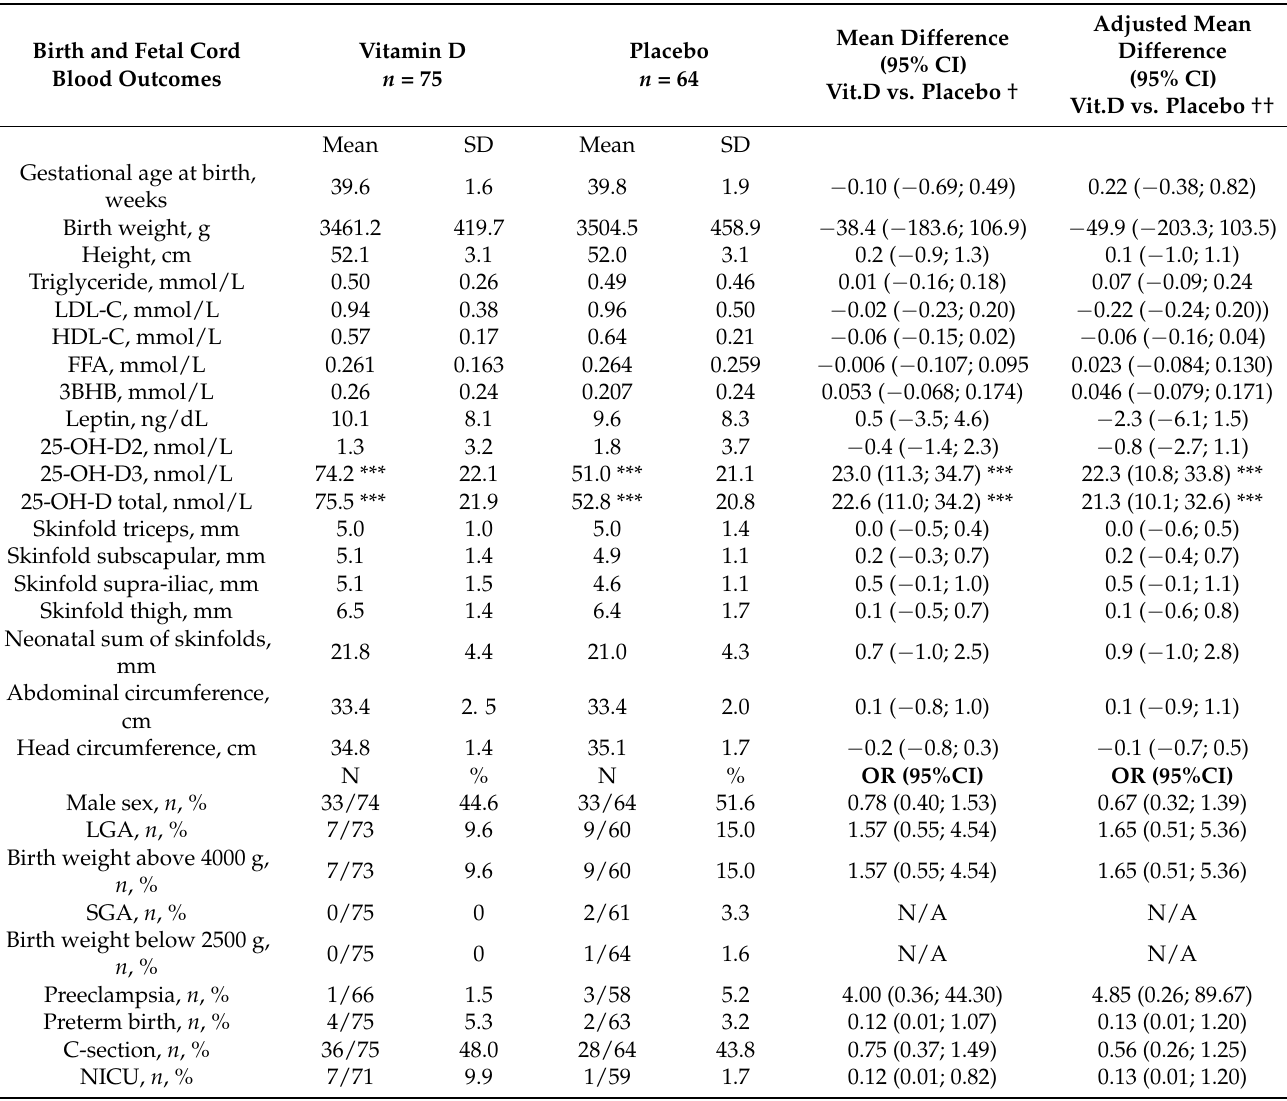
Table 4. Fetal cord blood, birth and pregnancy outcomes in the two intervention groups and mean differences between intervention